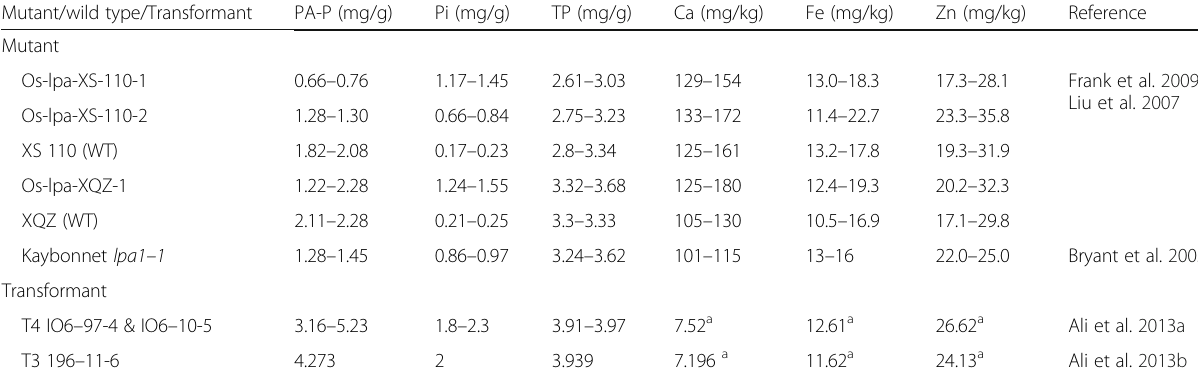
Table 2 PA-P, Pi, Total P (TP) and Micronutrient Contents in some Mutants, Transformants and Wild Type Rice Mutant/wild type/Transformant PA-P